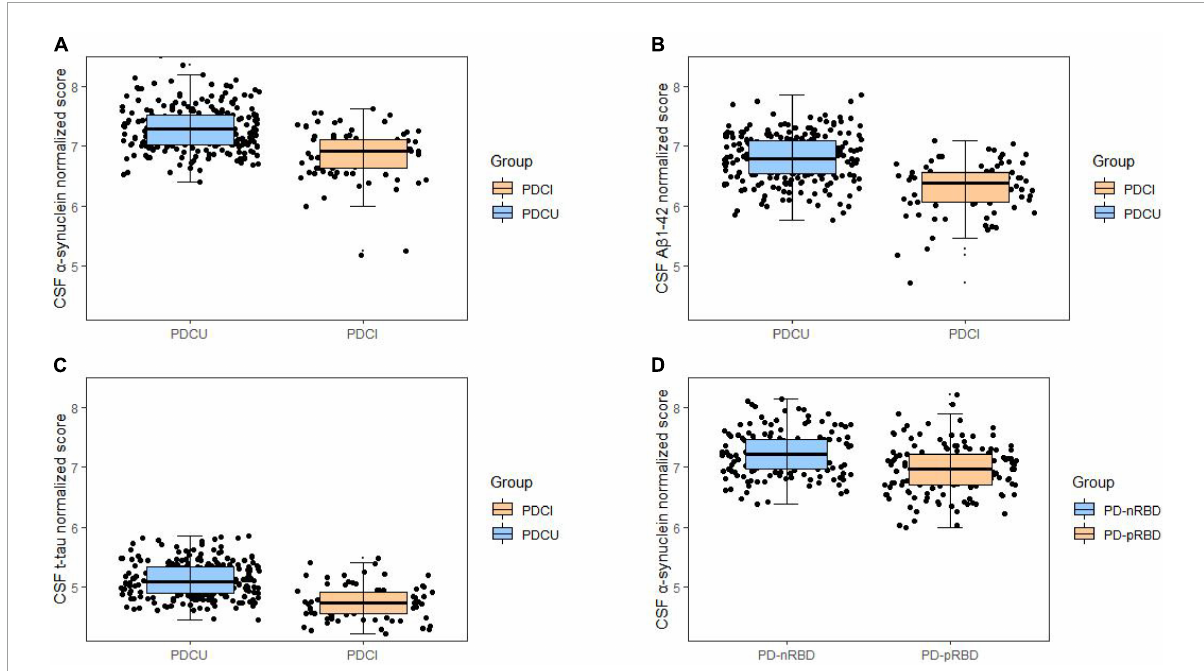
FIGURE2 Associations of cognitive impairments with lower cerebrospinal fluid (CSF) biomarker levels in cross-sectional analyses. Cognitive impairments were significantly associated with lower levels in (A) α -synuclein (B) , A β 1 − 42 , and (C) t-tau. Cross-sectional associations of sleep disorder with lower CSF (D) α -synuclein were shown. * P <